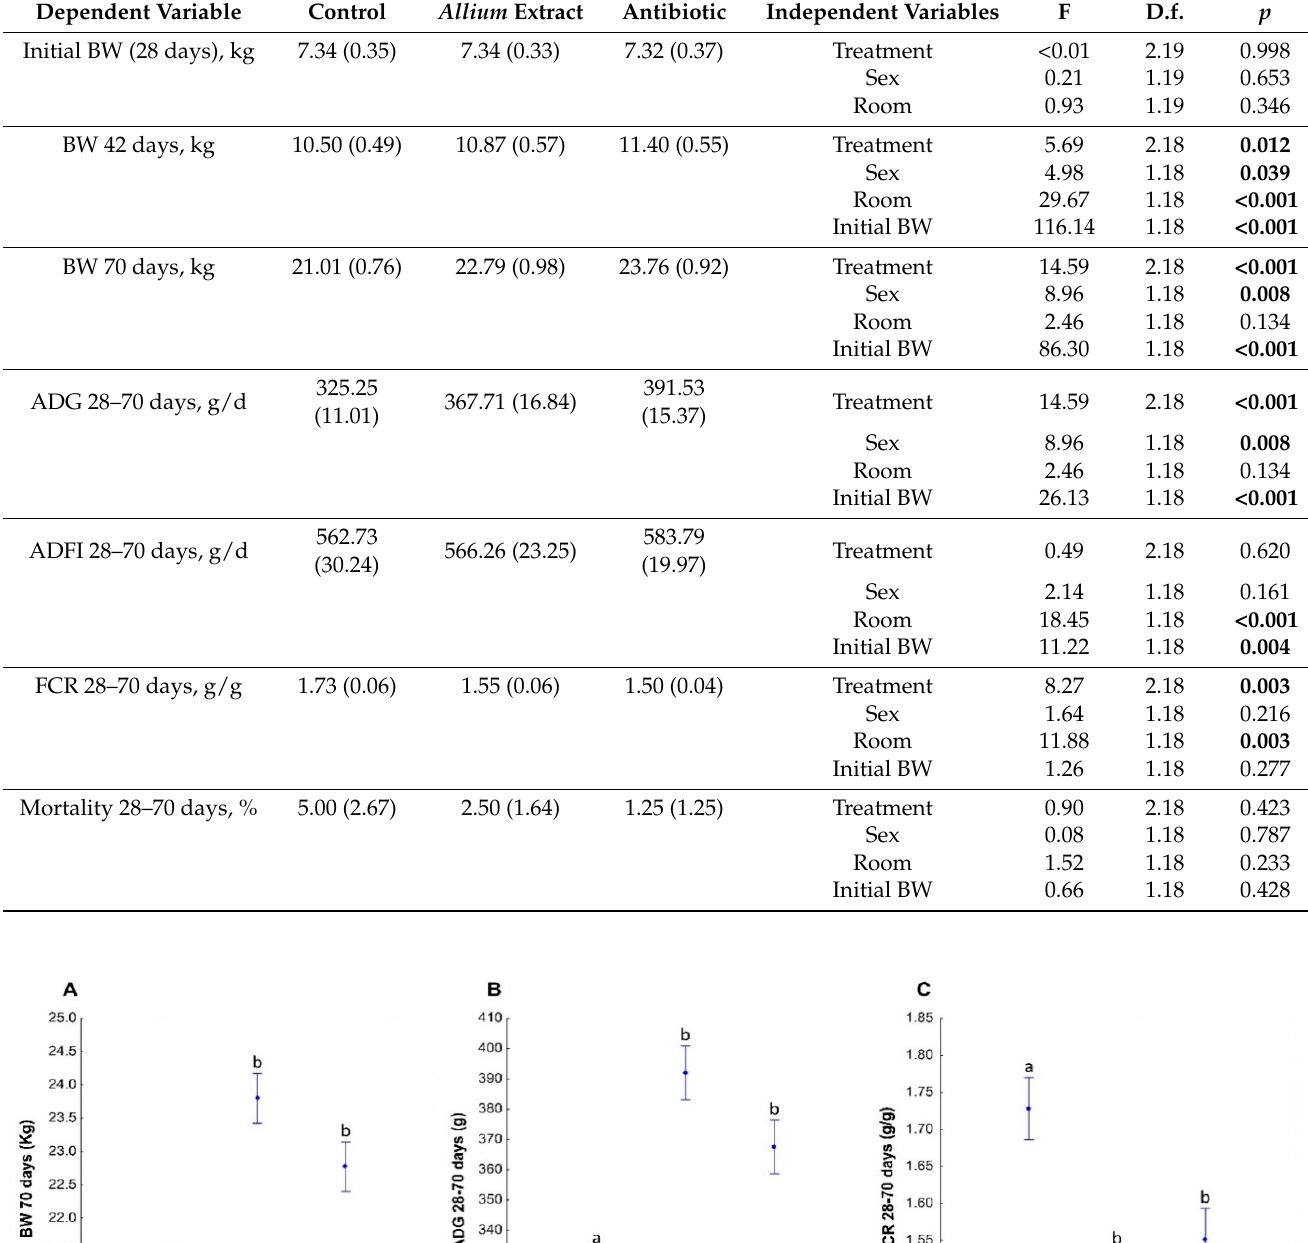
Table 4. General Linear Models exploring the effects of treatment as factor, sex, and block as random factors and initial body weight as covariate, in weaned piglets fed with control diet or supplemented with antibiotic or Allium extract. BW refers to body weight, ADG to average daily gain, FCR to feed conversion rate, and ADFI to average daily feed intake. D.f. refers to degree of freedom. The first number is the degree of freedom of the independent variable and the second one for the error term. Significant p -values are shown in bold.